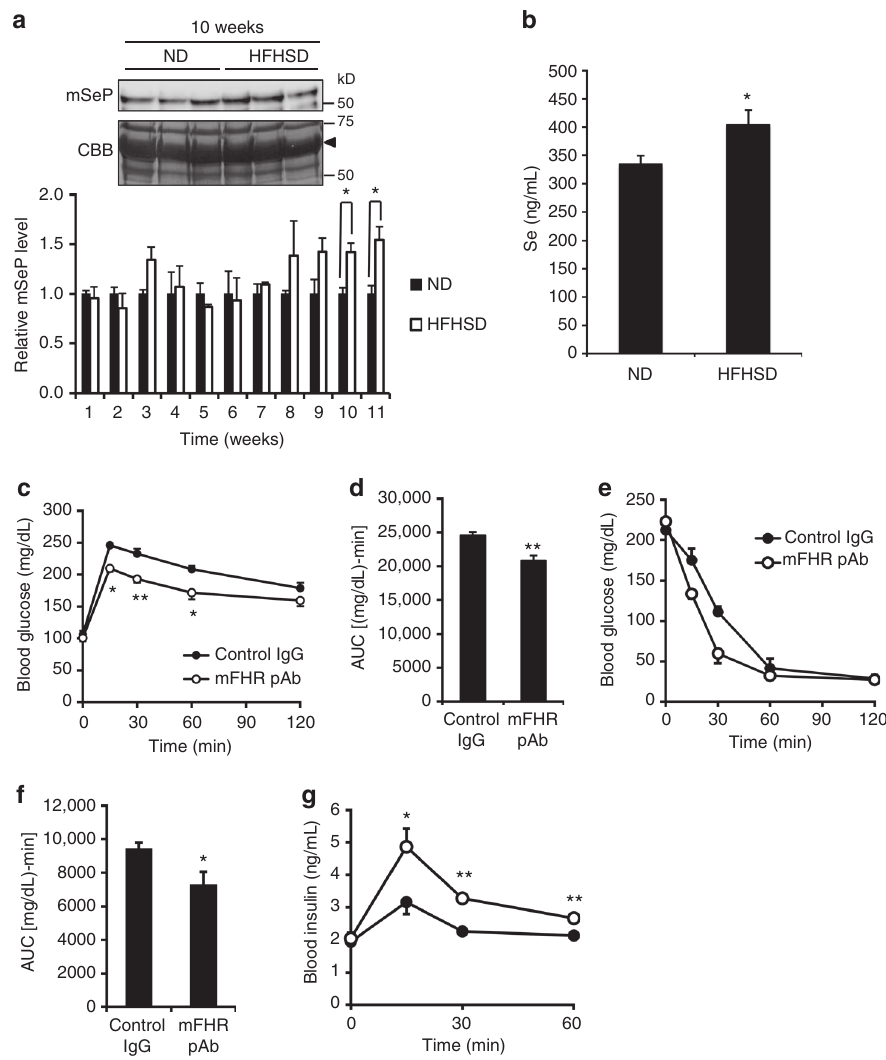
Fig. 8 Improvement of glucose metabolism in HFHSD-fed mice by SeP-neutralizing Ab. a Time-dependent change of plasma mSeP level in mice fed a high- fat, high-sucrose diet (HFHSD) and a normal diet (ND). CBB staining was used as a control for protein loading. Graphs display the results of densitometric quanti fi cation, normalized to the major protein (albumin, indicated by black arrowhead) stained with CBB ( n = 3, means ± s.e.m.). * P < 0.05, Tukey- ANOVA. b Elevation of plasma Se levels in mice fed an HFHSD. Plasma Se in mice fed an HFHSD and ND at 11 weeks was determined ( n = 5, means ± s.e. m.). * P < 0.05, Student's t -test. c , d Improvement of glucose tolerance in mice fed an HFHSD treated with mSeP-neutralizing Ab. Mouse SeP-neutralizing mFHR pAb or control rabbit IgG (25 mg/kg ip) was administered 24 h before glucose-tolerance tests following the scheme shown in Supplementary Fig. 8a. Glucose (0.3 g/kg body weight) was administered intraperitoneally, and blood glucose was determined at the indicated times ( c , n = 5, means ± s. e.m.). * P < 0.05, ** P < 0.01, Tukey-ANOVA. Area under the curve for blood glucose levels is shown in d ( n = 5, means ± s.e.m.). ** P < 0.01, Student's t - test. e , f Improvement of insulin sensitivity in mice fed an HFHSD treated with mSeP-neutralizing Ab. Mouse SeP-neutralizing mFHR pAb was administered 48 h before insulin tolerance tests following the scheme shown in Supplementary Fig. 8a. Insulin (10 U/kg ip) was administered, and then blood glucose was determined at the indicated times ( e , n = 5, means ± s.e.m.). The area under the curve for blood glucose levels is shown ( f , n = 5, means ± s.e.m.). * P < 0.05, Student's t- test. g Improvement of insulin secretion in mice fed an HFHSD by mSeP-neutralizing Ab administration. Blood insulin levels were determined during glucose tolerance tests ( n = 5, means ± s.e.m.). * P < 0.05, ** P < 0.01, Tukey-ANOVA. Closed circle, control IgG; open circle, mFHR pAb ( c , e , g )